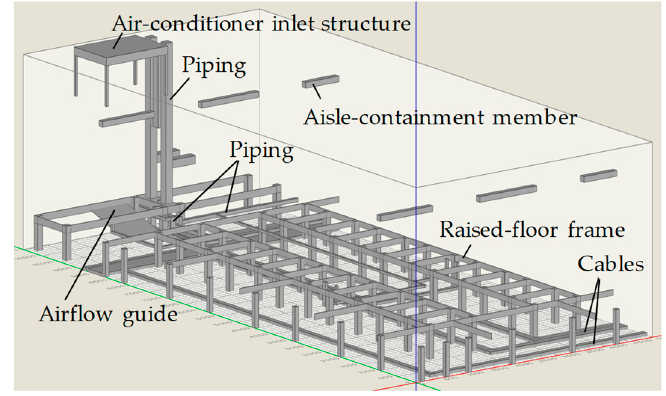
Figure 3. Model of obstructions.